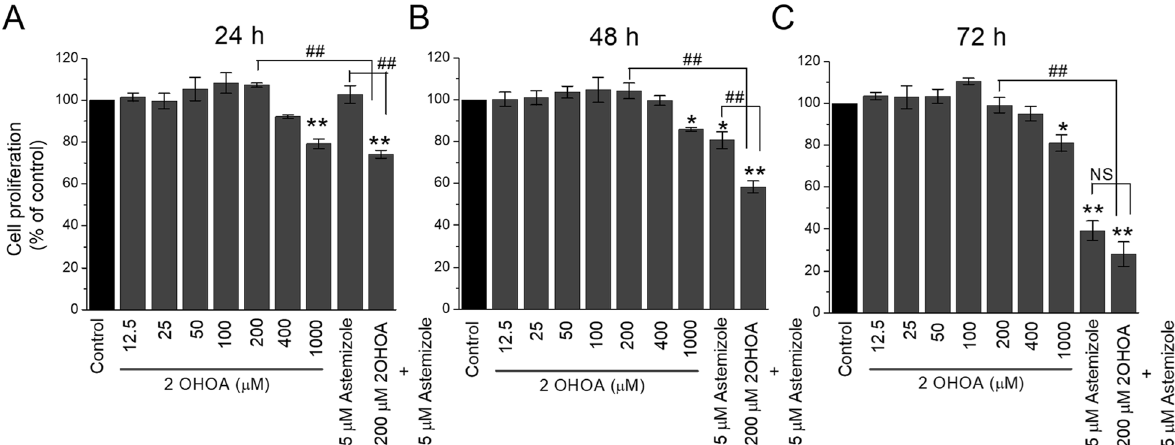
Fig. 4 2OHOA and astemizole synergistically decreases MCF‑7 cells proliferation. A – C proliferation of MCF‑7 cells treated with different concentrations of 2OHOA (12.5, 25, 50, 100, 200, 400 and 1000 µM), 5 µM astemizole and the combination 200 µM 2OHOA and 5 µM astemizole determined at 24 ( A ), 48 ( B ) and 72 h ( C ). Asterisks indicate significant effects compared with controls (* p < 0.05; ** p < 0.01), # indicates a significant effect of the combination of 200 µM 2OHOA 5 µM Astemizole compared to 200 µM 2OHOA or 5 µM Astemizole applied alone ( # p < 0.05; + ## p < 0.01), NS: Not significant. Data are represented as mean SEM ( n ± =